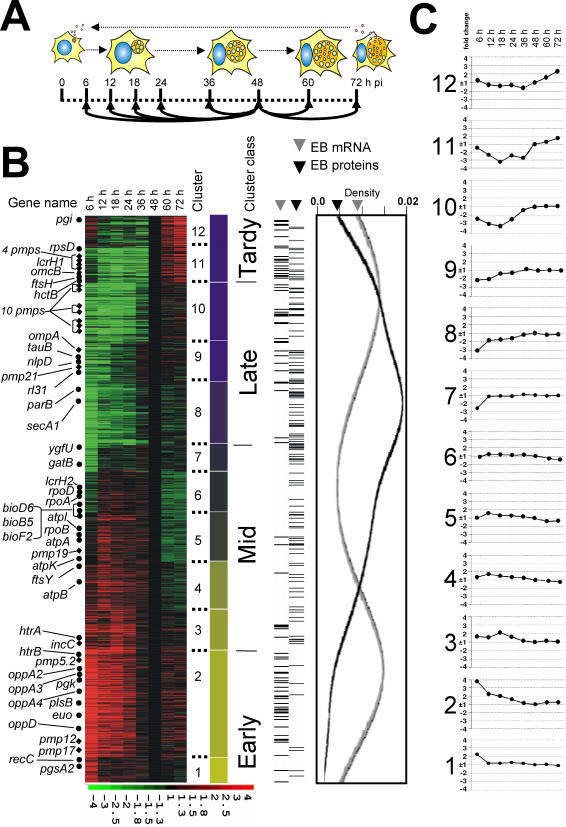
Analysis of Cpn Gene Expression in the Acute Infection(A) Cycle of development, time scale, and experimental design. Cells were infected and RNA extracted at the indicated time points, and 48 hpi was used as a reference time point. The arrows indicate the direction of the cycle of development.(B) Between 6 and 72 hpi, 754 significant expression profiles were determined using ratio profiles with SAM and SAMSTER and analyzed using SOM clustering (YDim = 12). Gene Cluster software using a one-class time-course analysis was carried out and plotted with TreeView software. Gene expression is displayed in fold change represented by the color bar beneath the figure with the expression at 48 hpi set to ±1. Names of genes mentioned in the text are depicted on the left, and cluster numbers, a color representation for the clusters, and cluster classes are depicted on the right of the cluster profile. Gene identification numbers, gene definitions, and gene names can also be viewed at http://www.ncbi.nlm.nih.gov. The cluster profile positions of 91 genes coding for mRNA (EB mRNA) and 127 genes coding for proteins present in the Cpn EB [63] (EB proteins) are displayed on the right of the cluster profile. A Gaussian Kernel Density Estimation for the EB mRNA and EB proteins positions in the cluster profile is represented by the graph on the right. Expanded annotated details for the gene lists and calculations are provided in Figures S8 and S9 and Tables S5 and S6.(C) Mean expression values of genes located in the defined clusters. For expanded annotated details, see Table S3A.